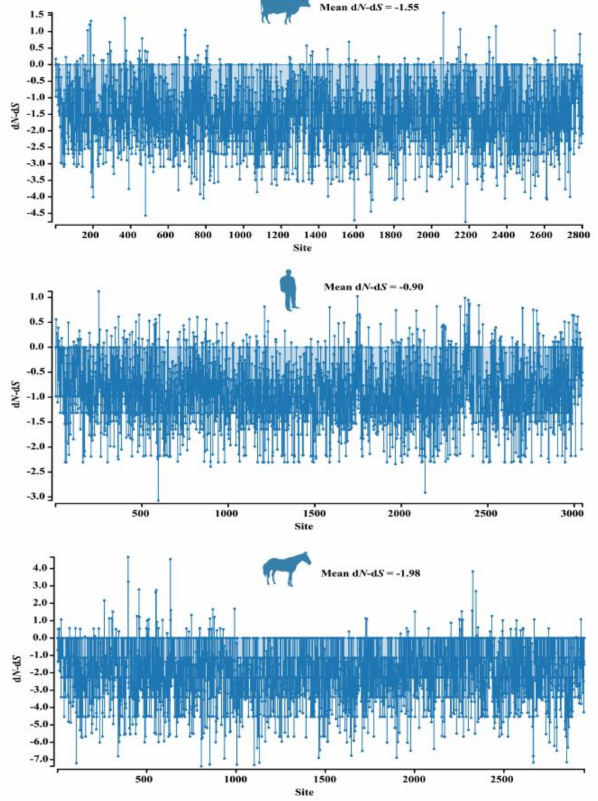
Figure 4. Differences between non-synonymous and synonymous (d N − d S ) rates plotted for the complete polyprotein-coding region of hepaciviruses identified in bovine, humans, and equine. d N